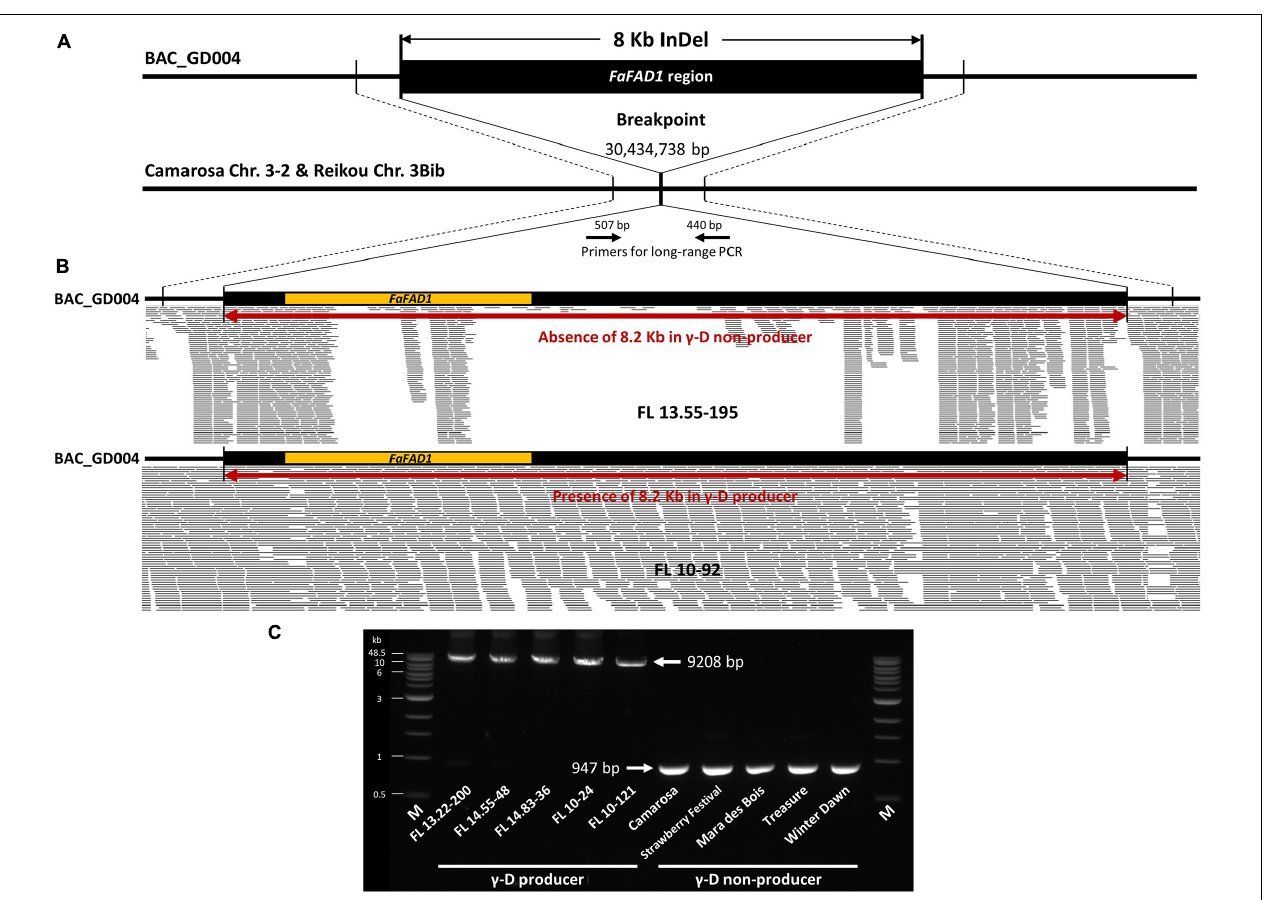
FIGURE 4 | Detecting a deletion of FaFAD1 . (A) Sequence alignment of a BAC clone, BAC_GD004, from library BB1 (‘Florida Brilliance’: γ -D producer) and corresponding regions of ‘Camarosa’ chromosome 3-2 and ‘Reikou’ haplotype 3Bib. An 8,262 bp deletion was detected in ‘Camarosa’ and ‘Reikou’, both γ -D non-producers. (B) Mapping Illumina sequence reads of γ -D producer (FL 10-92) and γ -D non-producer (FL 13.55-195) to BAC_GD004. (C) Long-range PCR results detect an 8,262 bp deletion between five γ -D producers and five γ -D non-producers. All PCR amplicons were similar to the expected size of 9,208 bp for γ -D producers and 947 bp for γ -D